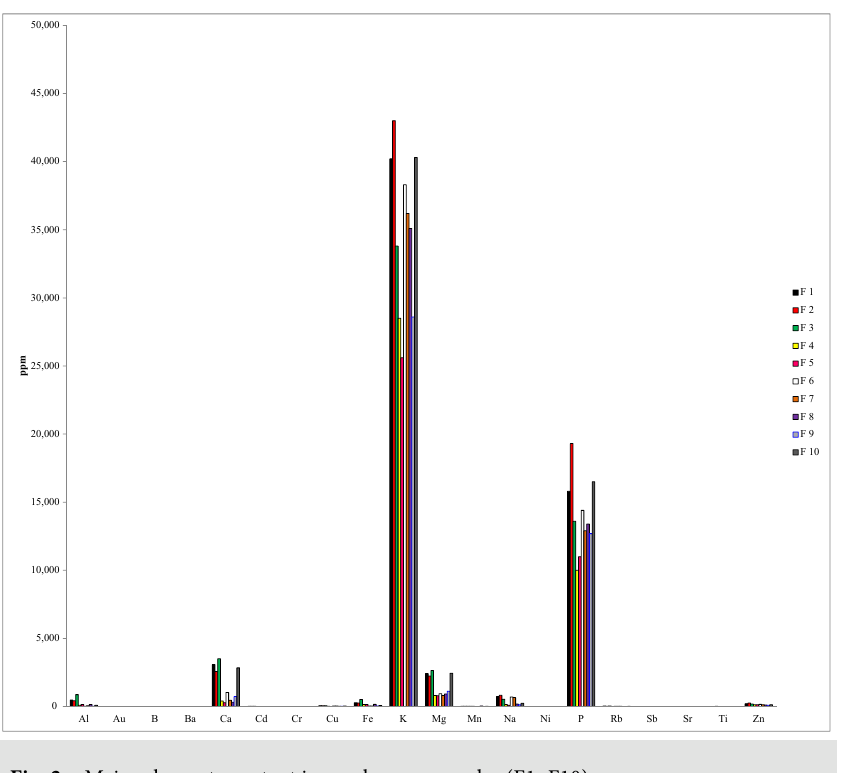
Fig. 2 Major elements content in mushroom samples